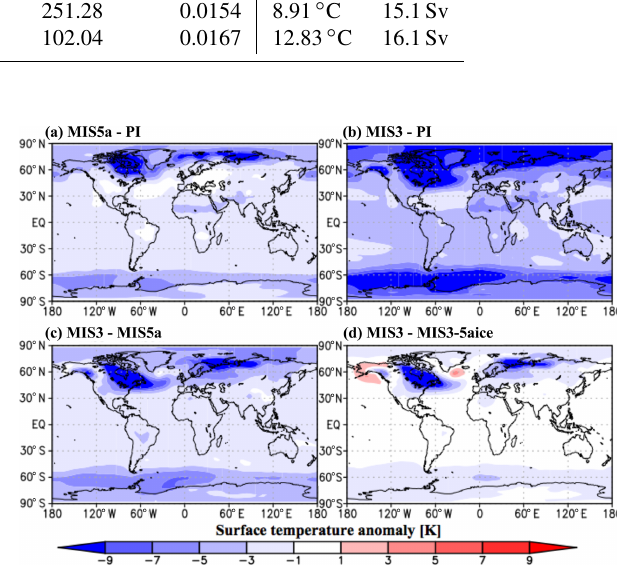
Figure 3. Surface air temperature anomalies calculated from the AOGCM. The 100-year climatology is used to calculate the anoma- lies. Panel (a) shows MIS5a minus PI, and panel (b) shows MIS3 minus PI. In panel (c) , the differences between MIS3 and MIS5a are shown. In panel (d) , the effect of ice sheet expansion from MIS5a to MIS3 is shown (MIS3 minus